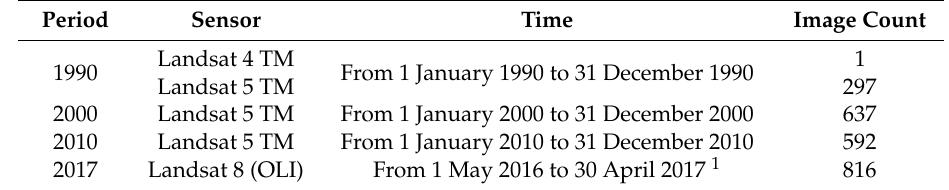
Table 1. Properties of image collections selected for this study.